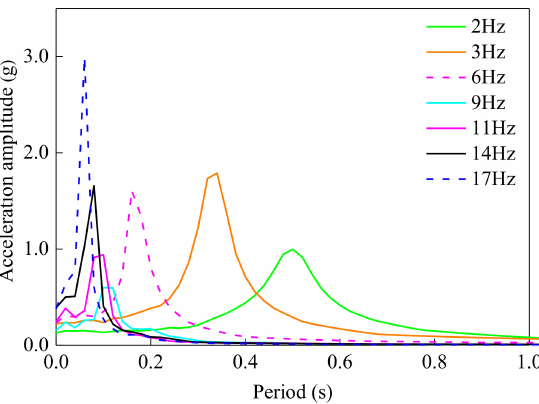
Figure 15. Response spectrum of ground surface acceleration under different